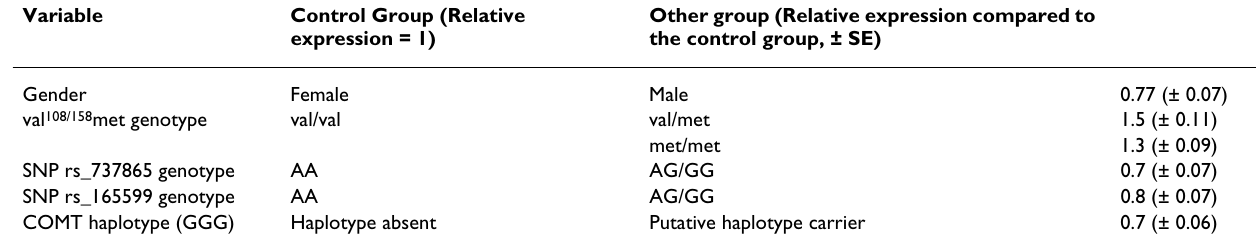
Table 1: Relative expression for gender and the three SNPs analysed using the comparative C T method ( ∆∆ C T ).